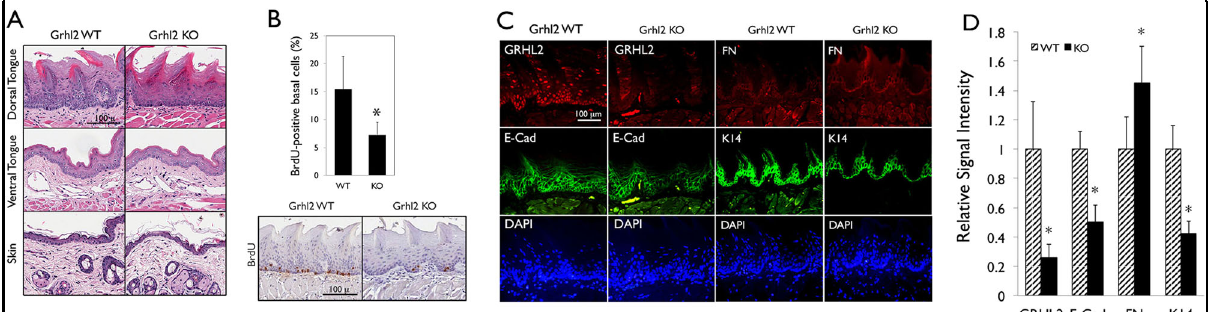
Fig. 2 Epithelial-speci fi c Grhl2 KO leads to retarded basal cell proliferation without gross histological defects in the epithelium. a Histology was shown after hematoxylin and eosin (H&E) staining of tongue epithelia (dorsal and ventral surfaces) and skin of Grhl2 WT and KO mice. b Grhl2 WT and KO mice were labeled with BrdU and the nuclear incorporation was determined by IHC of dorsal tongue epithelium. BrdU-positive cells were counted in each fi eld and plotted as % of all basal cells. Bar indicates mean/SD. * P o 0.05, statistical signi fi cance, compared with WT mice. c IFS was performed for GRHL2, E-Cad, FN, and K14 in dorsal tongue epithelia of Grhl2 WT and KO mice. d IFS signals were quantitated and plotted with the mean values for Grhl2 WT and KO mouse groups. Bar indicates mean/SD. * P o 0.05, statistical signi fi cance, compared with WT